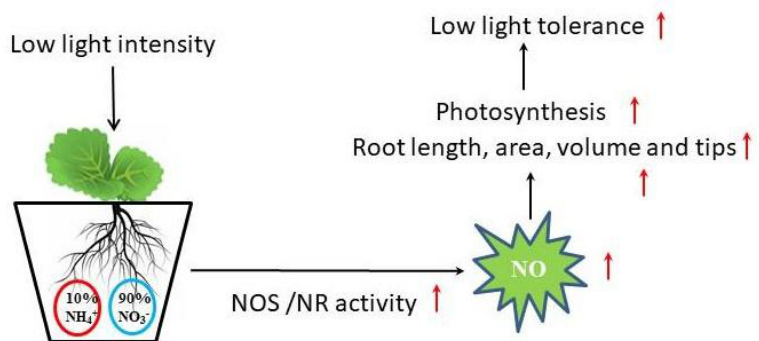
Figure 7. A proposed model illustrating how appropriate ammonium/nitrate ratio (10:90) alleviates low-light intensity stress in mini Chinese cabbage seedlings.